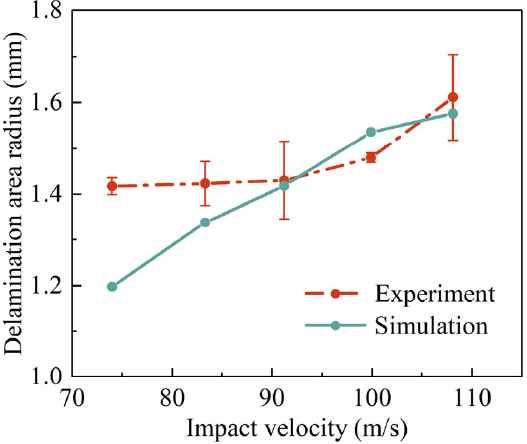
Figure 15. Experimental and predicted delamination area radius with different impact velocities.